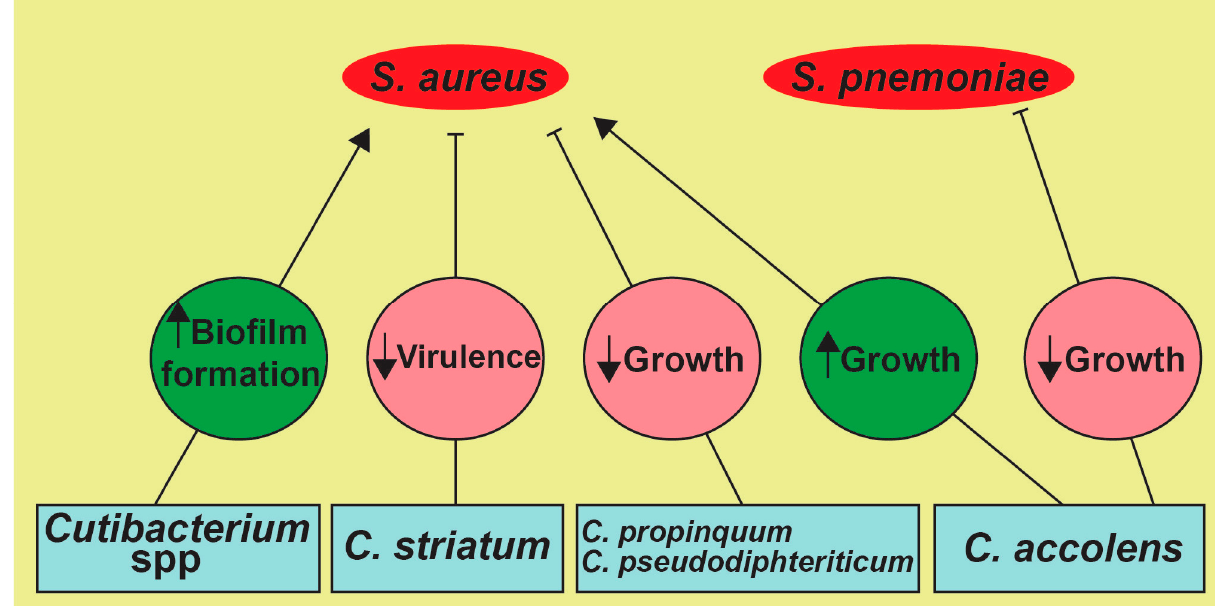
Figure 2. Possible microbial interactions in the UAs. The secretions of Staphylococcus lugdunesis (i.e., lugdunin, a thiazolidine) inhibits the growth of S. aureus [53]. Similarly, Corynebacterium spp. shifts S. aureus towards a more commensal state by attenuating its virulence components, such as the agr operon and genes involved in its hemolytic activity [50,54,55]. Moreover, Corynebacterium and Cutibacterium spp. affect the growth of S. aureus , as the most commonly secreted porphyrin by Cutibacterium spp. facilitates S. aureus aggregation and biofilm formation with other UA microbes [52,56,57].